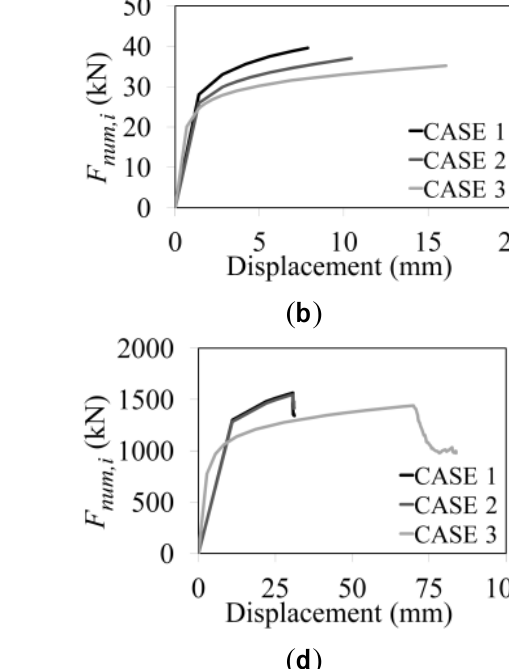
Figure 8. Numerical force-displacement curves: I-100 column section made of ( a ) 6082-T6 and ( b ) 6061-T4; HEM450 column section made of ( c ) 6082-T6 and ( d ) 6061-T4; HEA100 column section made of ( e ) 6082-T6 and ( f ) 6061-T4; HEB400 column section made of ( g ) 6082-T6 and ( h ) 6061-T4; IPE200 column section made of ( i ) 6082-T6 and ( j )